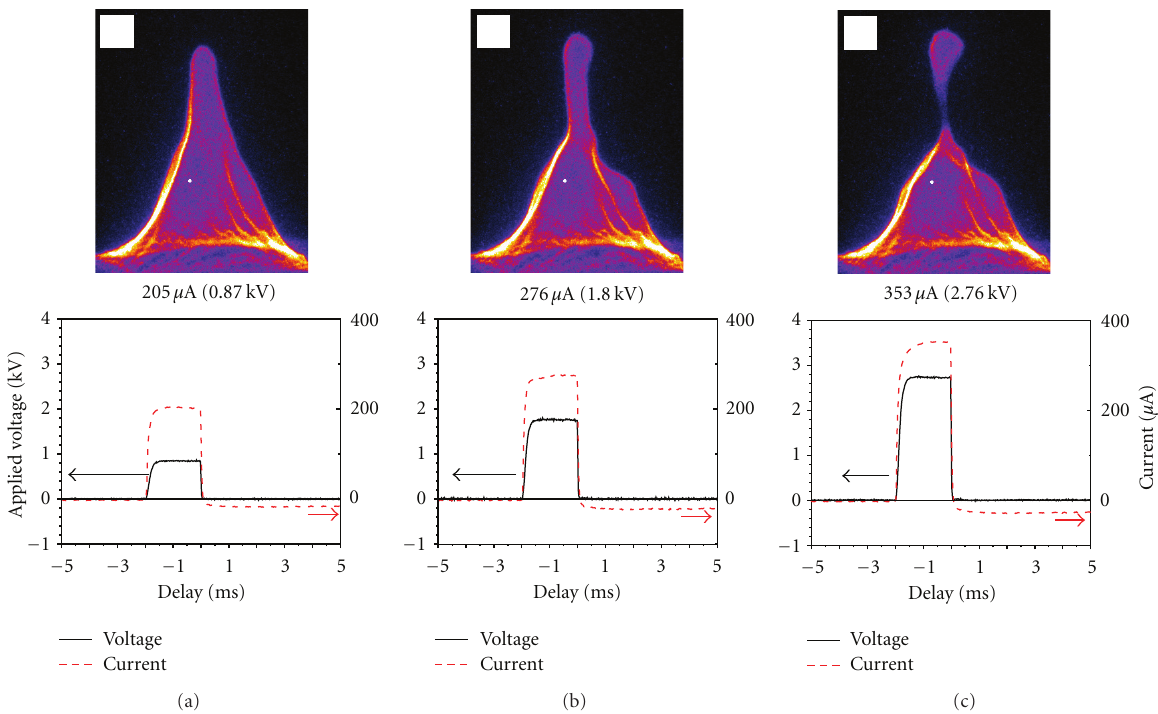
Figure 4: This data sequence details the e ff ect of variable voltage-current on flame perturbation. As the applied voltage is increased from 870V (with 205 μ A current) up to +2.7kV (with 353 μ A current) the level of flame reaction zone perturbation also rises eventually leading to flame pinch o ff . All images were taken with a 4 ms wide voltage pulse applied to a Φ = 1.1 flame with the same time delay (2ms) from the end of the applied voltage. The white box in the upper left corner of each image is 5mm by 5